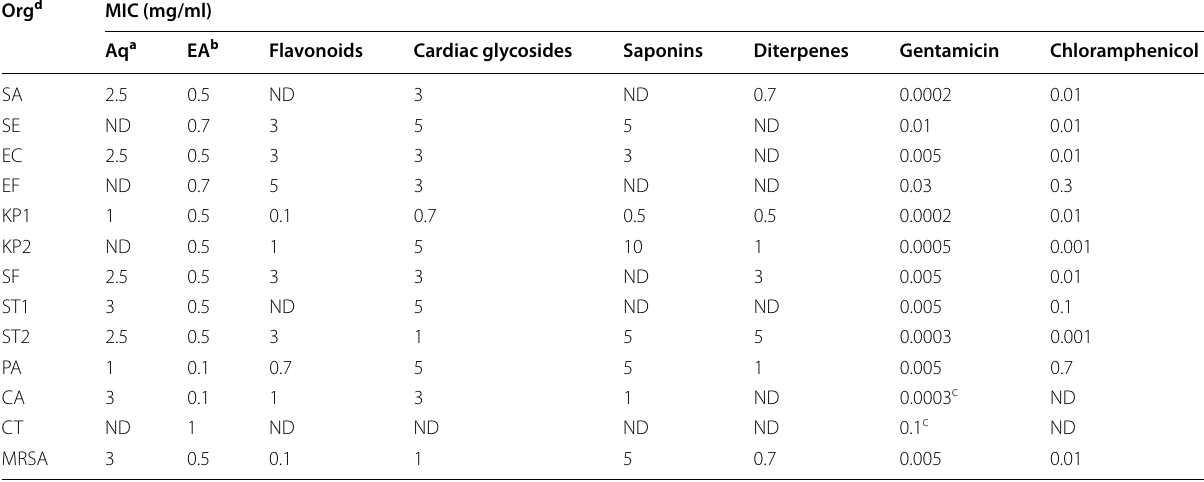
ND not determined a Aqueous extract